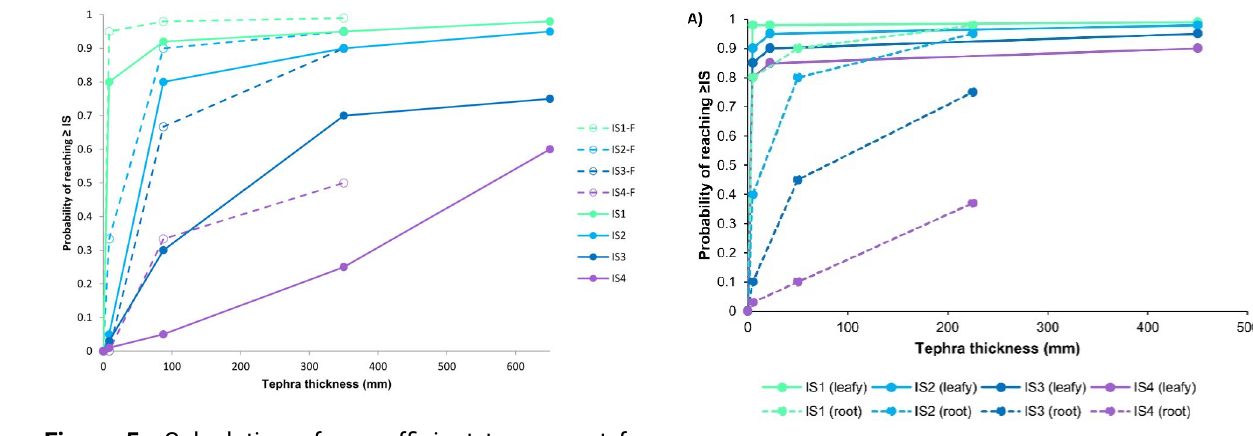
Figure 5: Calculation of a coefficient to account for the higher vulnerability of pastoral farms caused by tephra fall with high leachable fluoride (>150 mg/kg). Fragility functions for high leachable fluoride events compared to functions for low leachable fluoride events (<150 mg/kg) for large, high intensity pastoral farming. See Table 8 for calculated values. Table 8: Calculated fluoride toxicity coefficient values for fragility functions for large, high intensity, non-dairy pastoral farms, created by subtracting line segments shown in Figure 5.